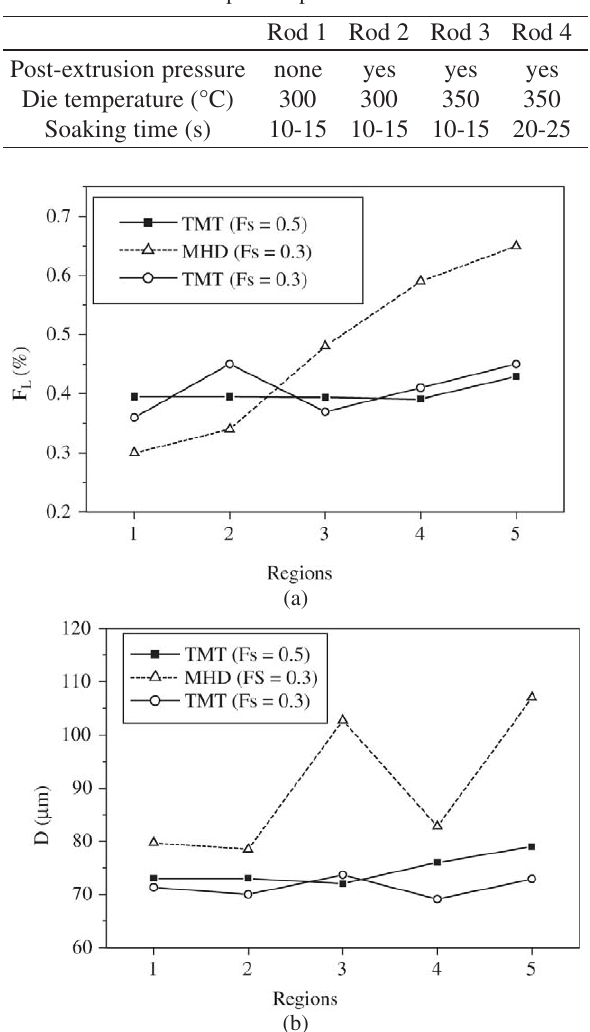
Table 2. Thixoextrusion process parameters.